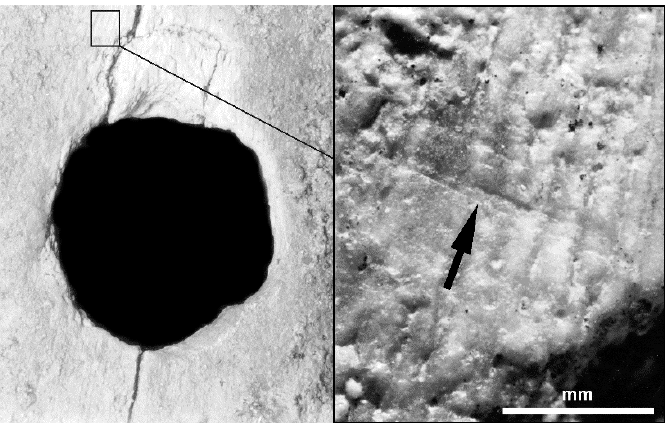
Figure 5. Depression near hole no. 3 on the posterior side of the diaphysis and location of two parallel micro-scores on the abraded surface of cortical bone (marked with an arrow) (ZRC SAZU, Archive of Institute of Archaeology).